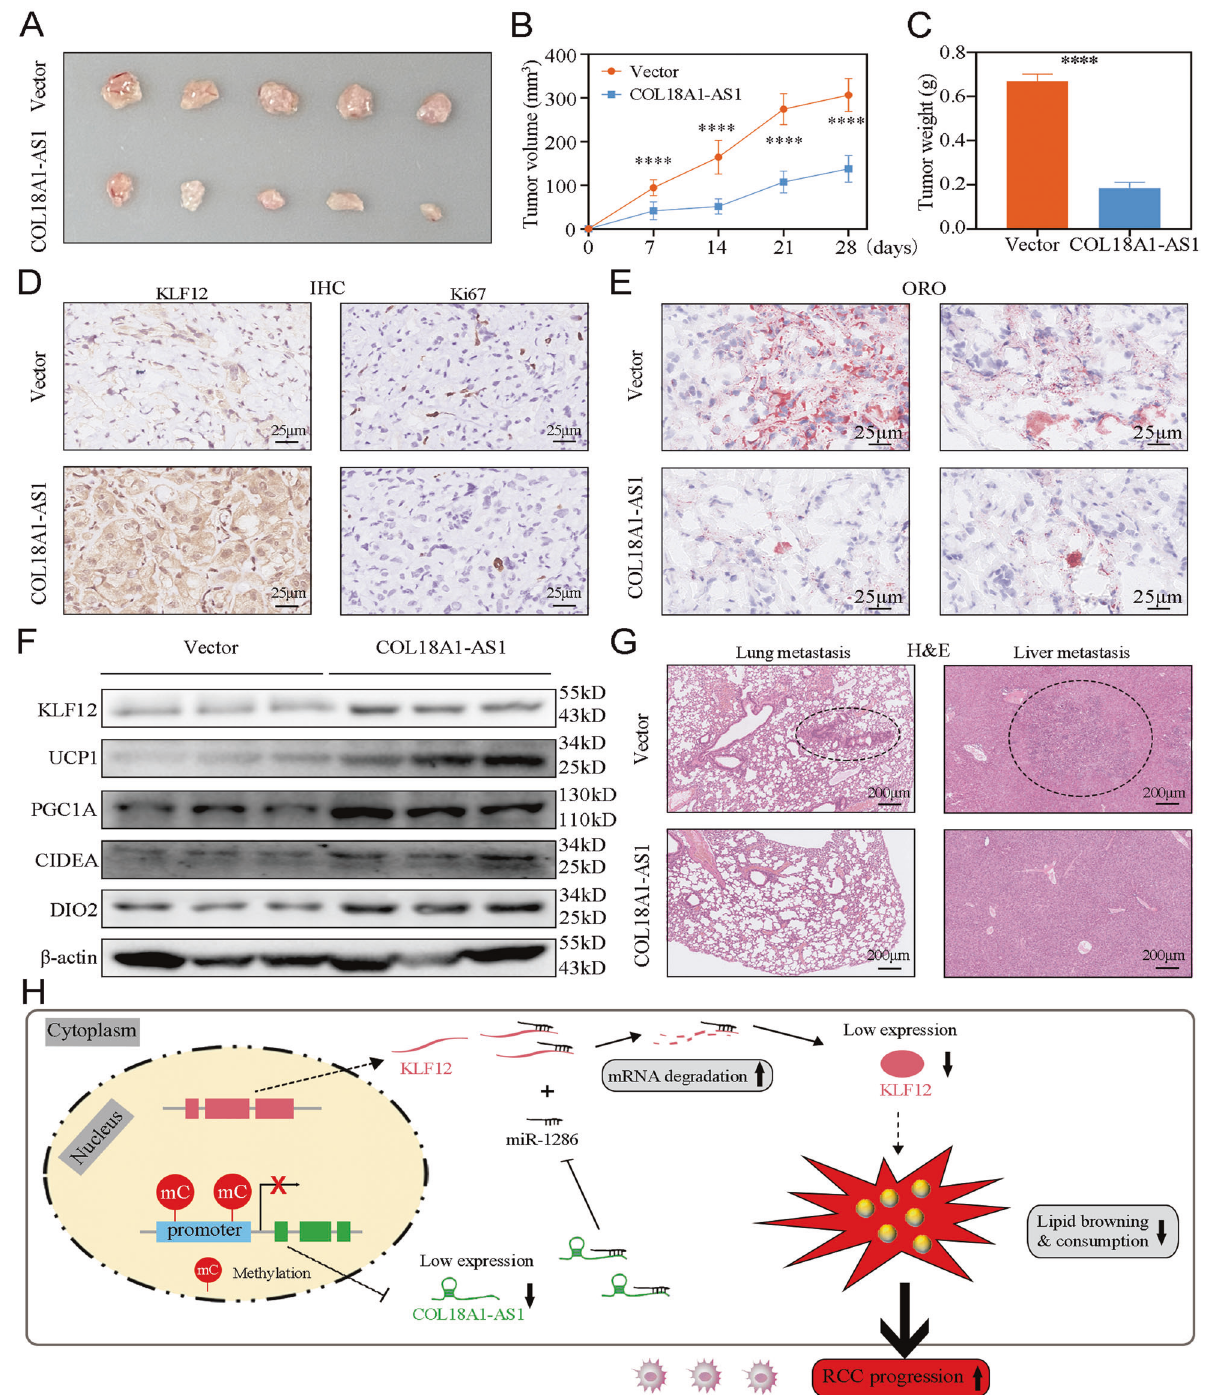
Fig. 7 COL18A1-AS1 promoted tumor slimming and repressed ccRCC progression in vivo. A OS-RC-2 cells with COL18A1-AS1 stably overexpressed were subcutaneously injected into nude mice. B , C The volume and weight of xenograft tumors in two groups ( n = 5). D IHC assays were performed to measure KLF12 and the marker of tumor malignancy (Ki67) expression levels in two groups. Scale bars, 25 μ m. E Oil Red staining of the tumor xenografts from the COL18A1-AS1-overexpressing and control groups. Scale bars, 25 μ m. F Western blotting assays were performed to measure KLF12 and the markers of lipid browning (UCP1, PGCIA, CIDEA, and DIO2) expression levels in two groups. G H&E staining of the lung metastasis and liver metastasis from the COL18A1-AS1-overexpressing and control groups. Scale bars, 200 μ m. H Schematic diagram illustrated that methylation of the COL18A1-AS1 promoter region in ccRCC inhibited the expression of COL18A1-AS1, thus leaded to lipid abnormal accumulation and RCC progression via miR-1286/KLF12 axis. * P < 0.05, ** P < 0.01, *** P < 0.001, **** P < 0.0001. Error bars indicate mean ± SD. All the experiments were performed in